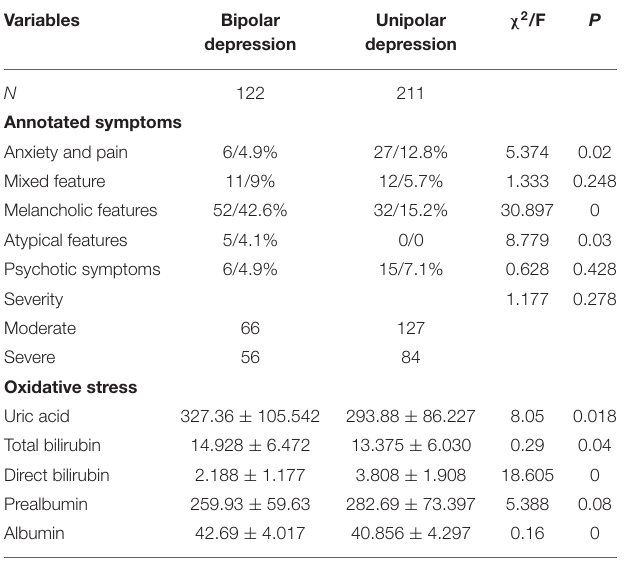
TABLE 4 | Symptoms and oxidative stress related indicators in patients who developed unipolar and bipolar depression in autumn.